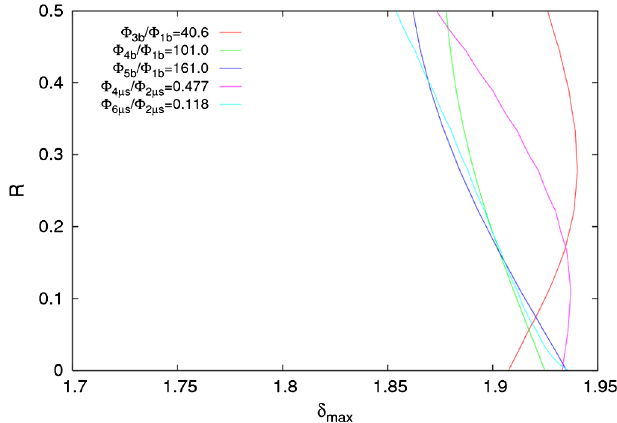
FIG. 4. Combinations of (cid:1) - R values characterizing the max chamber surface, obtained by benchmarking ratios of observed pressure increases against ratios of simulated electron fluxes, for measurements on 6 April